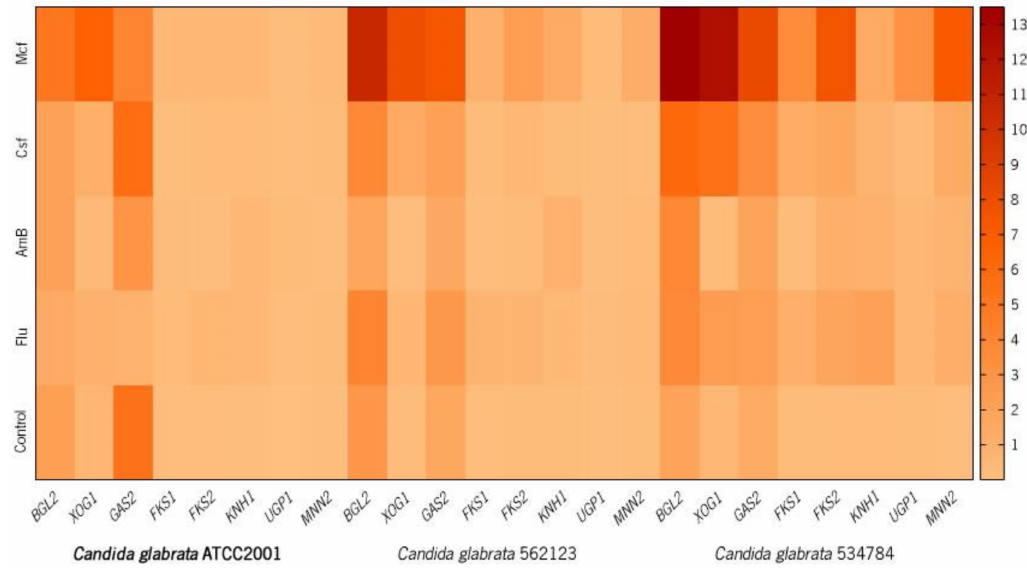
Figure 1. Real-time PCR expression profiling of BGL2 , XOG1 , GAS2 , FKS1 , FKS2 , KNH1 , UGP1 , and MNN2 genes in biofilm cells of Candida glabrata ATCC2001 (reference strain, in bold) (a), C. glabrata 562123 (b), and C. glabrata 534784 (c) in the presence of antifungal drugs. The heatmap was generated by a log transformation of the RT-qPCR data and the fold-change (FC) expression determined through 2 − ∆ C T . The numerical scale on the right represents the FC. (Control: non-treated cells). Generally, BGL2 , FKS1 , FKS2 , GAS2 , and XOG1 displayed higher expression levels in